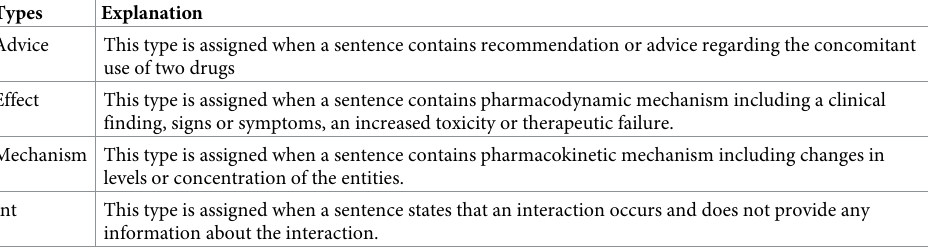
Table 1. DDI relation types and